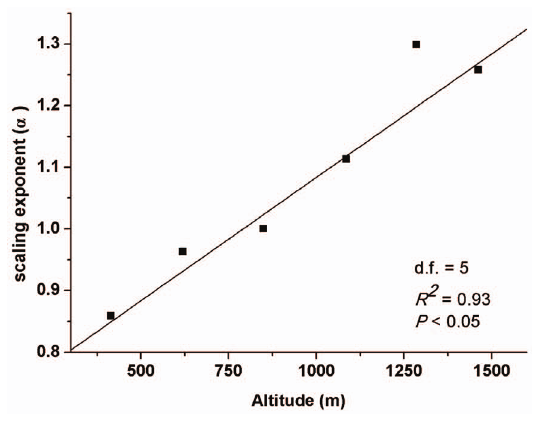
Figure 2. Scaling exponent ( a ) of the leaf mass-area relation- ship increases with